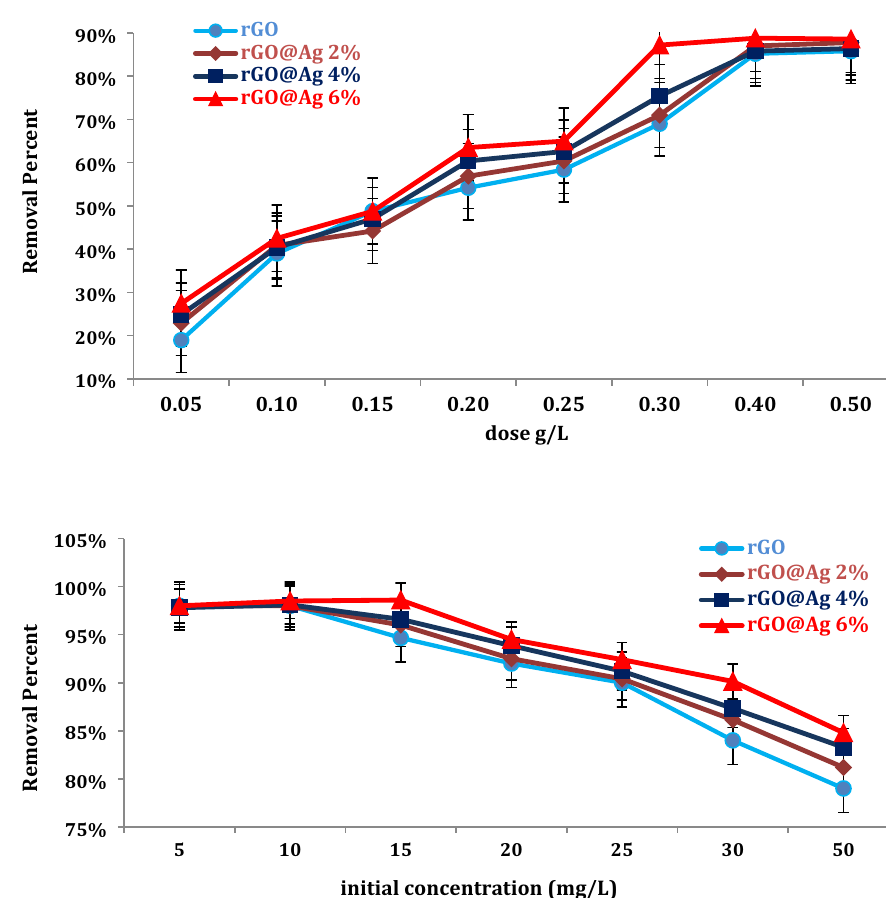
Fig. 10 Photodegradation of Congo red dye using different photocatalyst doses